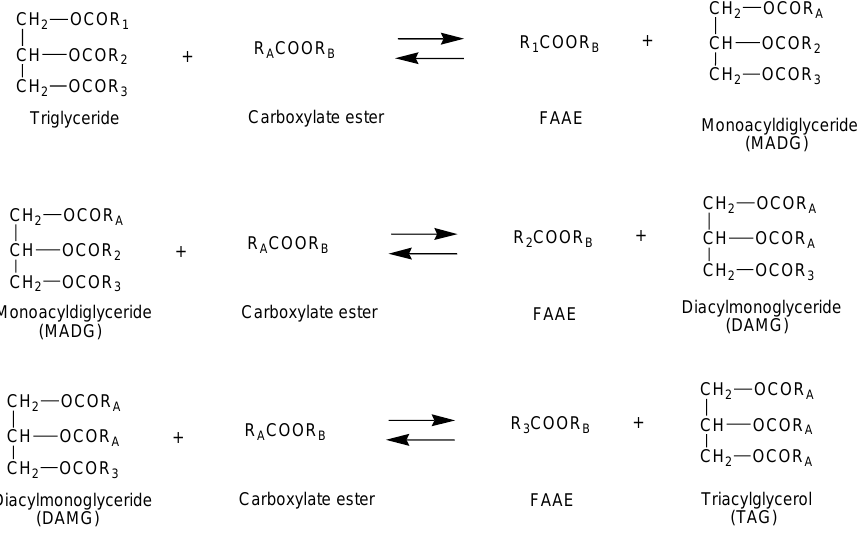
Figure 1. Triglyceride interesterification reaction with carboxylate esters.